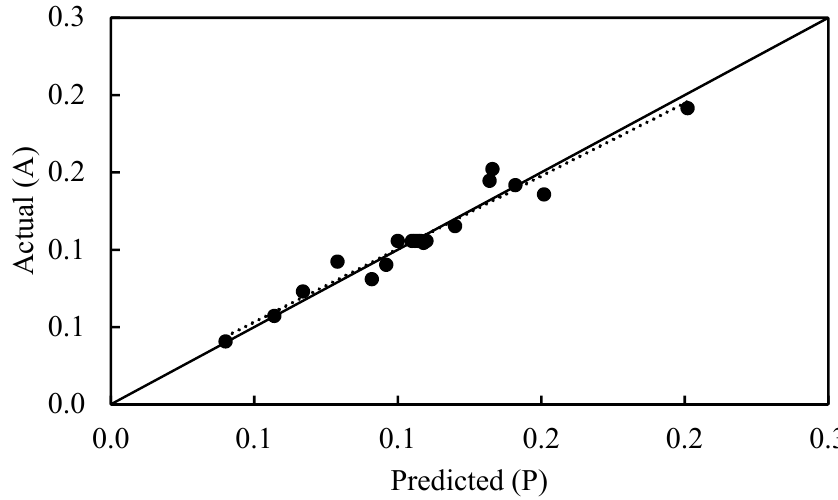
Figure 2. Linear correlation between the actual and predicted effective diffusion coefficient. – A = P, ··· best linear fit, • data point.